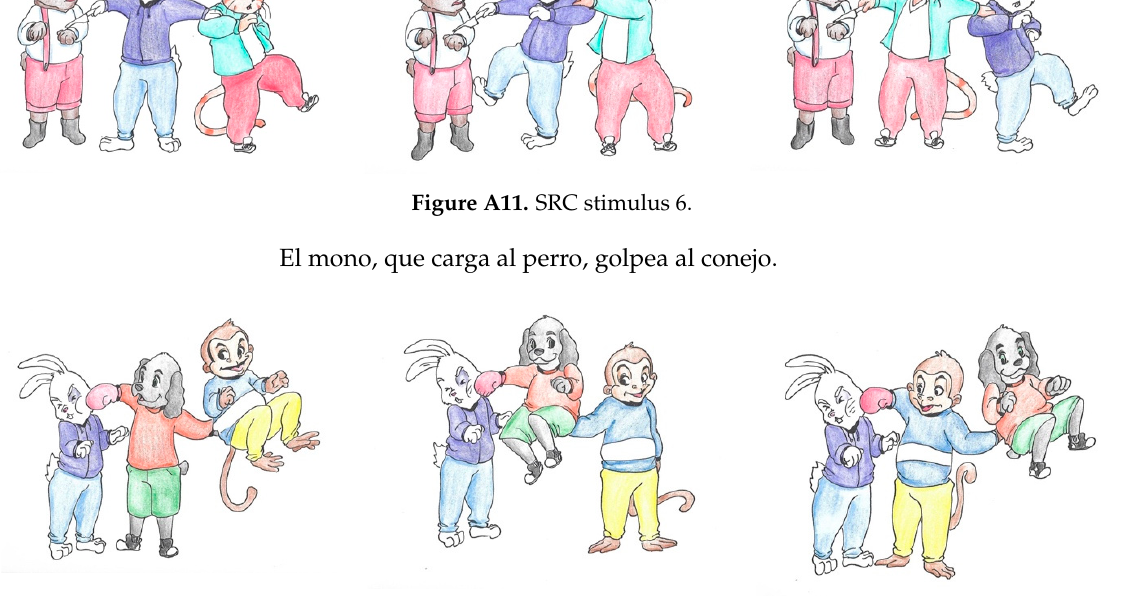
Figure A12. SRC stimulus 7.